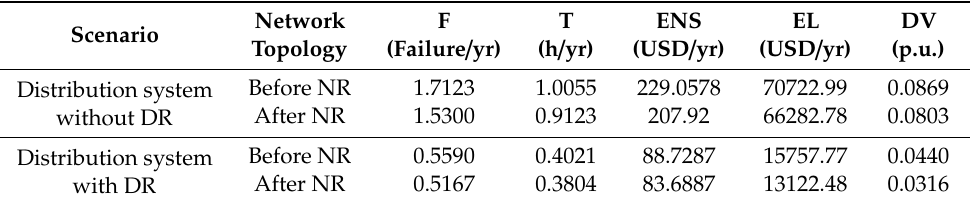
Table 10. It can be observed from the table that an enhancement of about 10% is obtained using NR in distribution systems without DRs. After DR placement, the e ff ectiveness of NR is found to be increased marginally by about 2–3%. Table 10. Comparison